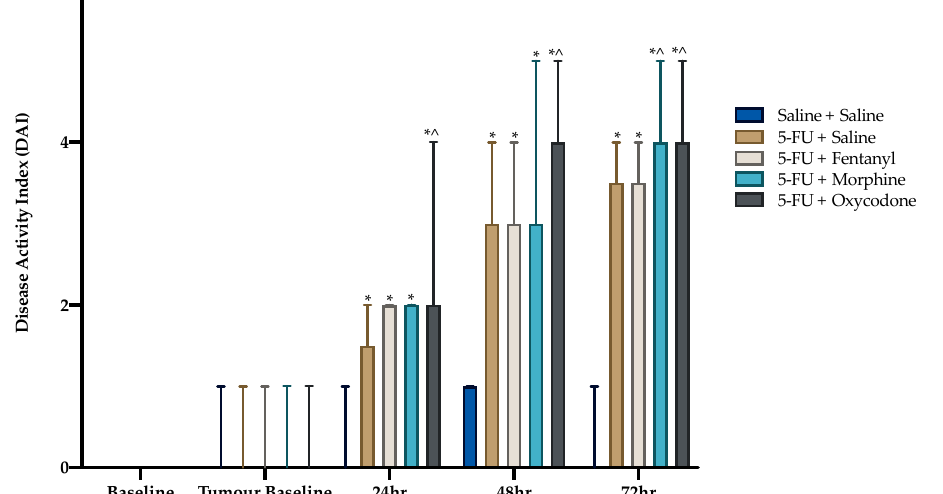
Figure 3. Disease activity index scores. Data expressed as median with range. Symbols denote significance obtained using a Kruskal-Wallis test with a post-hoc Mann Whitney U-test, between groups, at each time point. * p < 0.05 compared to saline. ^ indicates p < 0.05 compared to 5-FU alone. Statistical comparison within group across time not shown (refer to Table 2). Saline + Saline (n = 11), 5-FU + Saline (n = 12), 5-FU + Fentanyl (n = 12), 5-FU + Morphine (n = 12) and 5-FU + Oxycodone (n = 12) at all time-points.